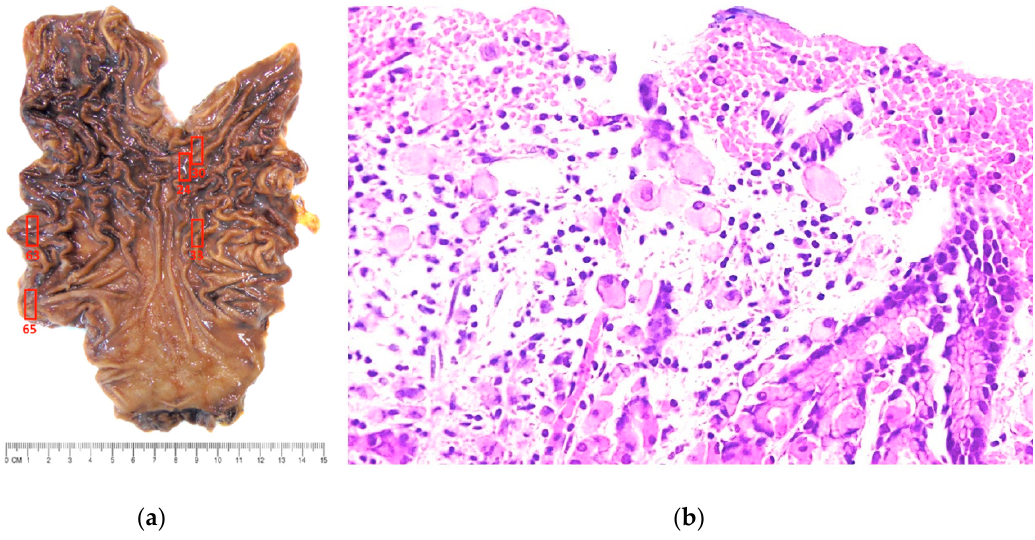
Figure 3. ( a ) Prophylactic gastrectomy specimen with no visible macroscopic abnormalities. Complete mapping revealed five regions where microscopic foci of intramucosal signet ring cell carcinoma was found (red boxes). ( b ) Photomicrograph shows foci of signet-ring cell carcinoma, involving the gastric mucosa (stage IA disease) (Hematoxilin-eosin stain, 100X).